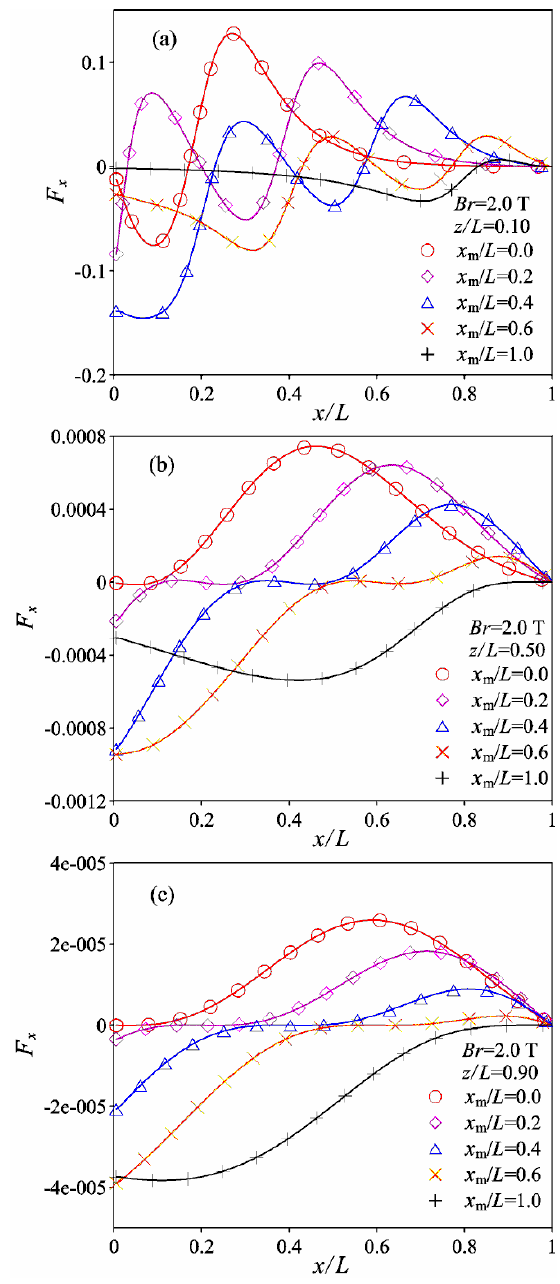
Figure 9. Distribution of F x on the selected lines; ( a ) z / L = 0.1, ( b ) z / L = 0.5, and ( c ) z / L = 0.9.